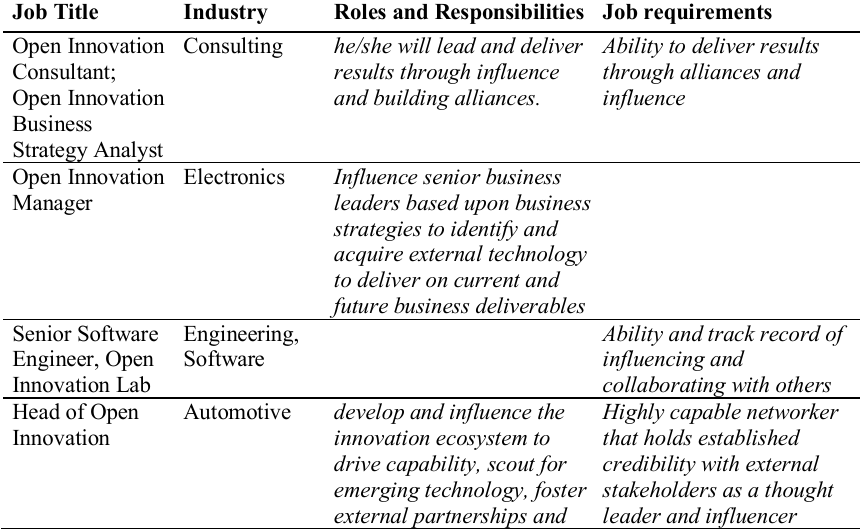
Table 3. List of job titles mentioning the ‘ability to influence others’ in jobs posted in